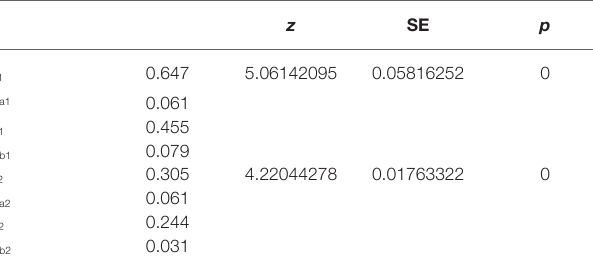
TABLE 7 | Sobel test results (model